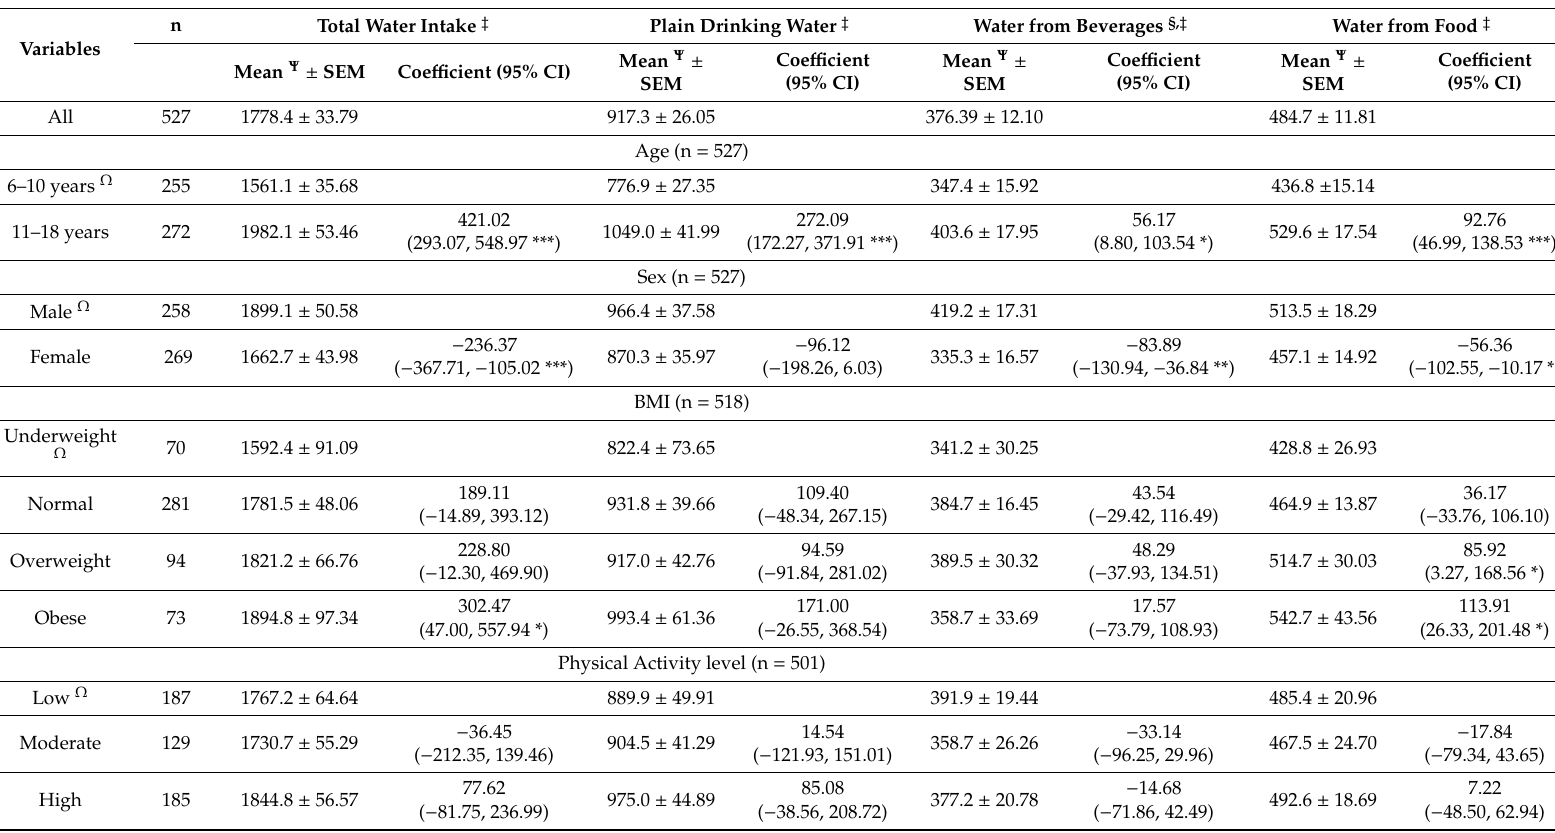
Table 1. Simple linear regression of water intake from drinking and the consumption of food and beverages, by sociodemographic